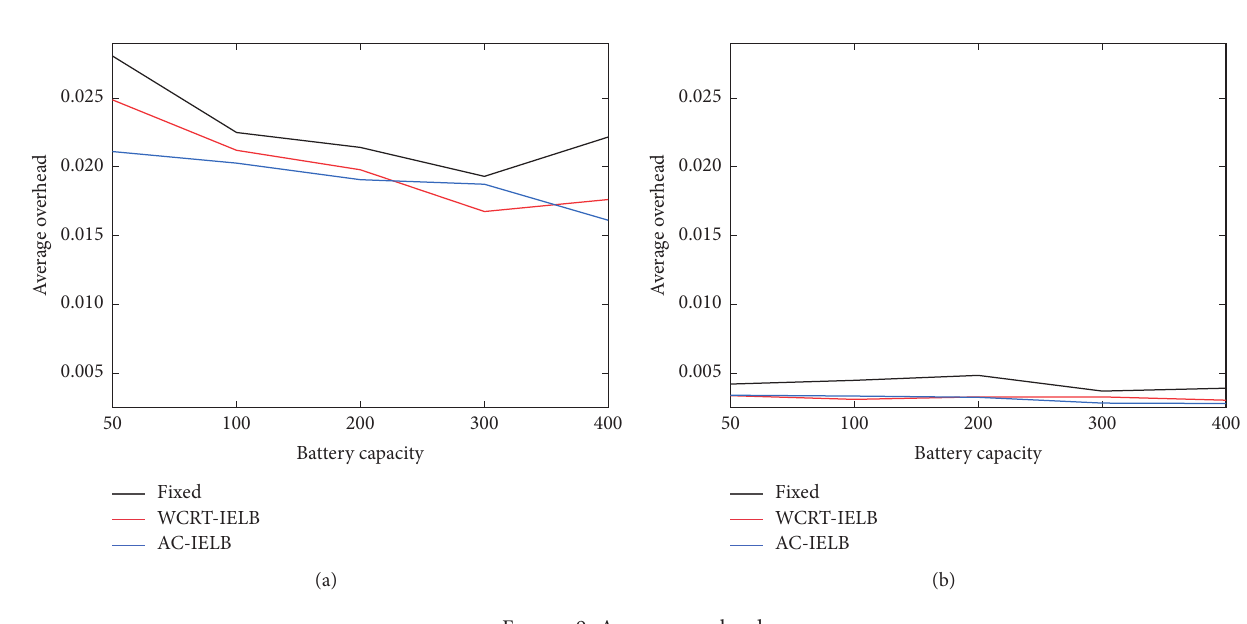
Figure 8: Average energy level.